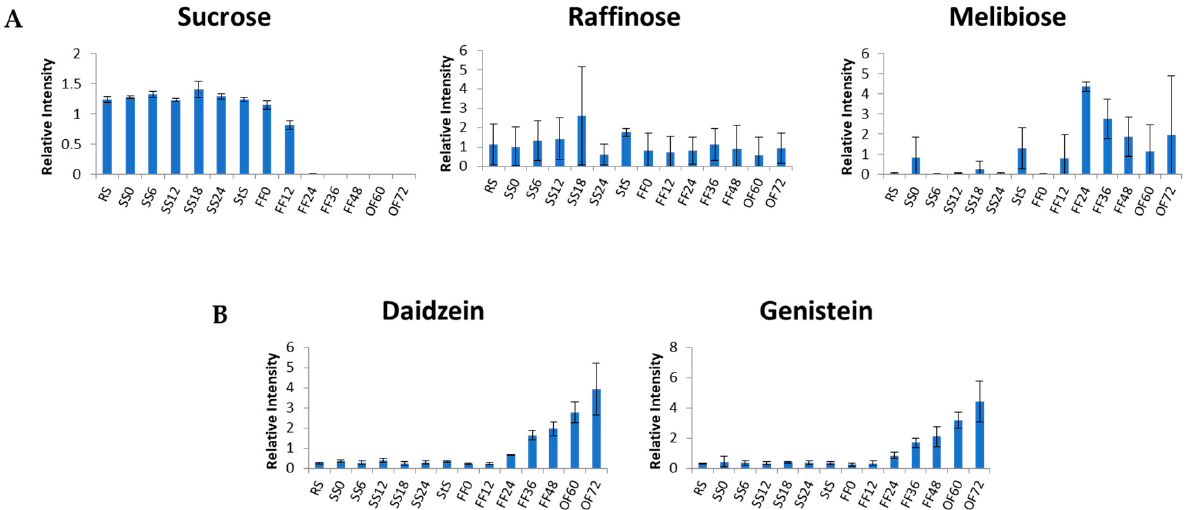
Figure 8. ( A ) Oligosaccharides contribute to flatulence. ( B ) Isoflavone aglycone. The vertical axis represents relative intensity. The horizontal axis represents the samples. The error bar shows the standard deviation obtained from three replicates.